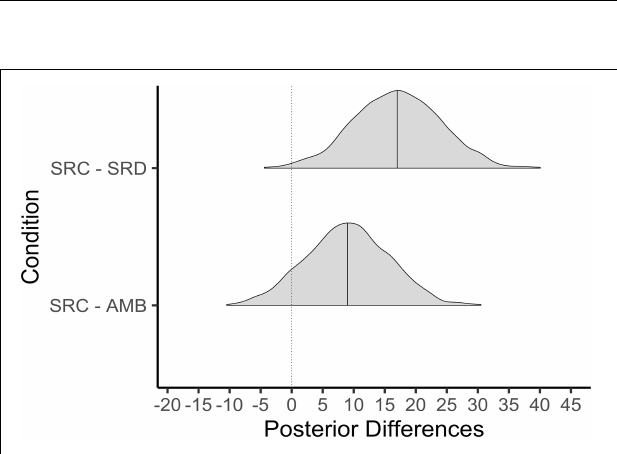
FIGURE 6 | Posterior differences in ‘Rest and Digest’ by condition. Solid line represents the 50th percentile and the dotted line is 0 = no difference.